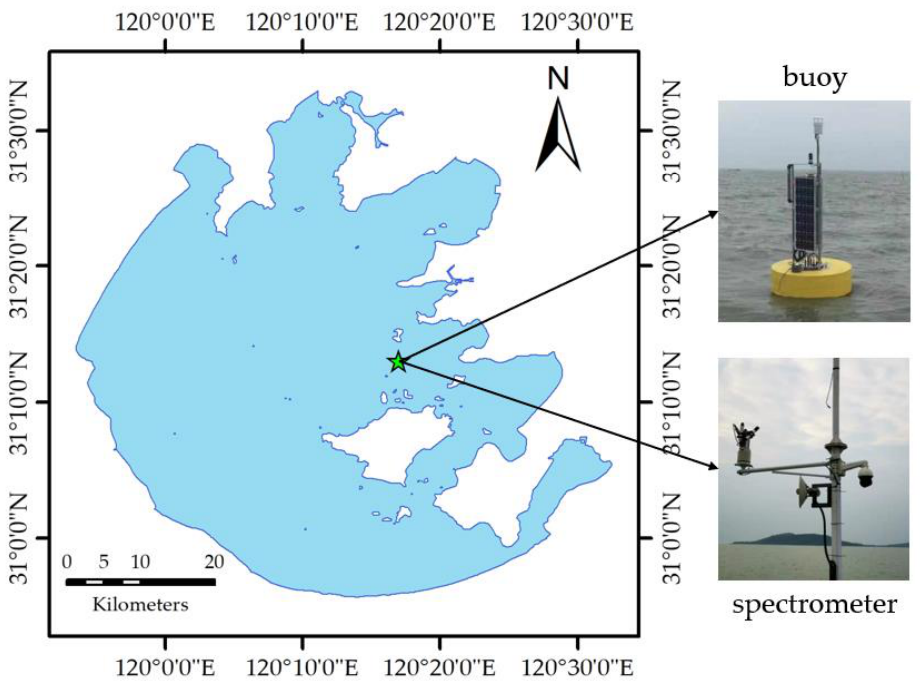
Figure 1. Location of the experimental area and the measuring instruments in Taihu Lake.